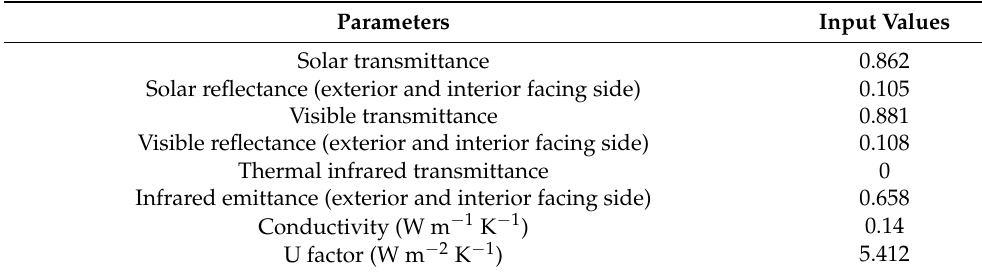
Table 2. Properties of the covering material for the experimental greenhouse